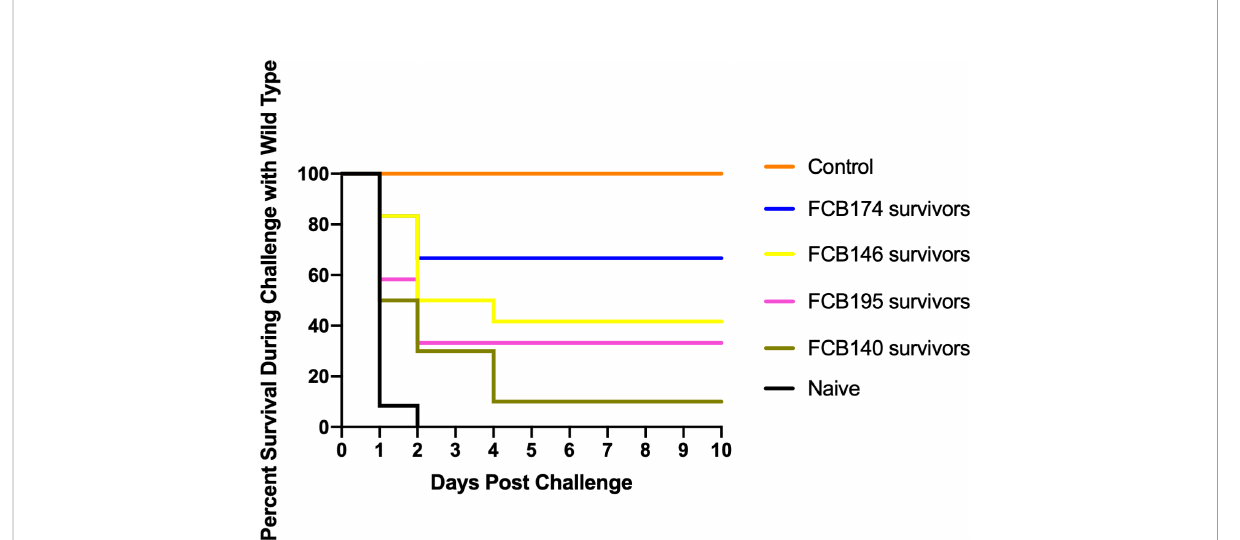
FIGURE 10 Challenge of zebra fi sh survivors with wild type F. columnare . Fish that survived exposure to mutants predicted to be de fi cient in multiple steps of iron uptake were examined for later resistance to challenge with wild-type cells. Naïve fi sh, FCB140 survivors, FCB146 survivors, FCB 174 survivors, and FCB195 survivors were maintained for 28 days and then exposed to F. columnare wild type (2.1 x 10 6 CFU/ml). Naïve fi sh were not previously exposed to F. columnare . Control indicates fi sh exposed to D gldN mutant (6.3 x 10 6 CFU/ml) instead of to wild type. Signi fi cant differences in the percent survival were seen for the naïve fi sh and FCB146 survivors (P < 0.001), naïve fi sh and FCB174 survivors (P < 0.0001), and naïve fi sh and FCB195 survivors (P <